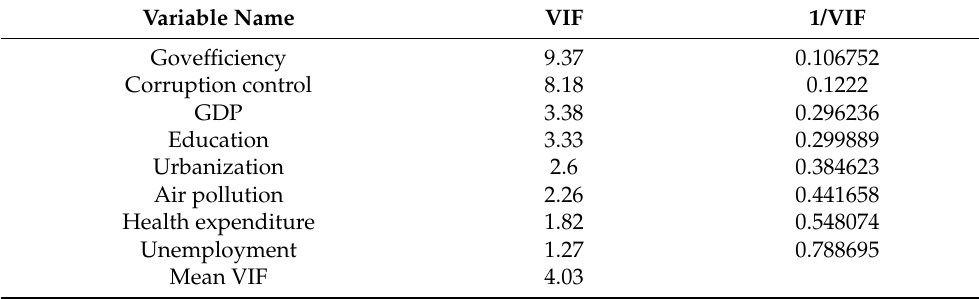
Table 2. Multicollinearity